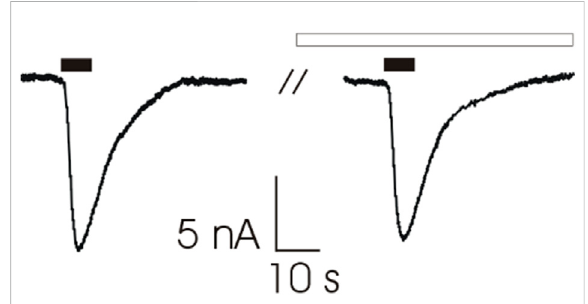
FIGURE 4 Representative traces of ACh-evoked currents (200 μ M, 7s, black bars) recorded from Xenopus oocytes microtransplanted with muscle tissue (tibialis anterior muscle; 2 individuals) before (Left) and after (Right) 120 s of pre-incubation with 3,4-DAP (100 ng/ml, white bar). Holding potential (V H ) was -60 mV. Note that 3,4-DAP did not affect ACh-evoked current ’ s amplitude (13.1 ± 2.6 nA versus 12.2 ± 2.3 before and after pre-incubation respectively, n = 12; p = 0.256, Wilcoxon signed rank